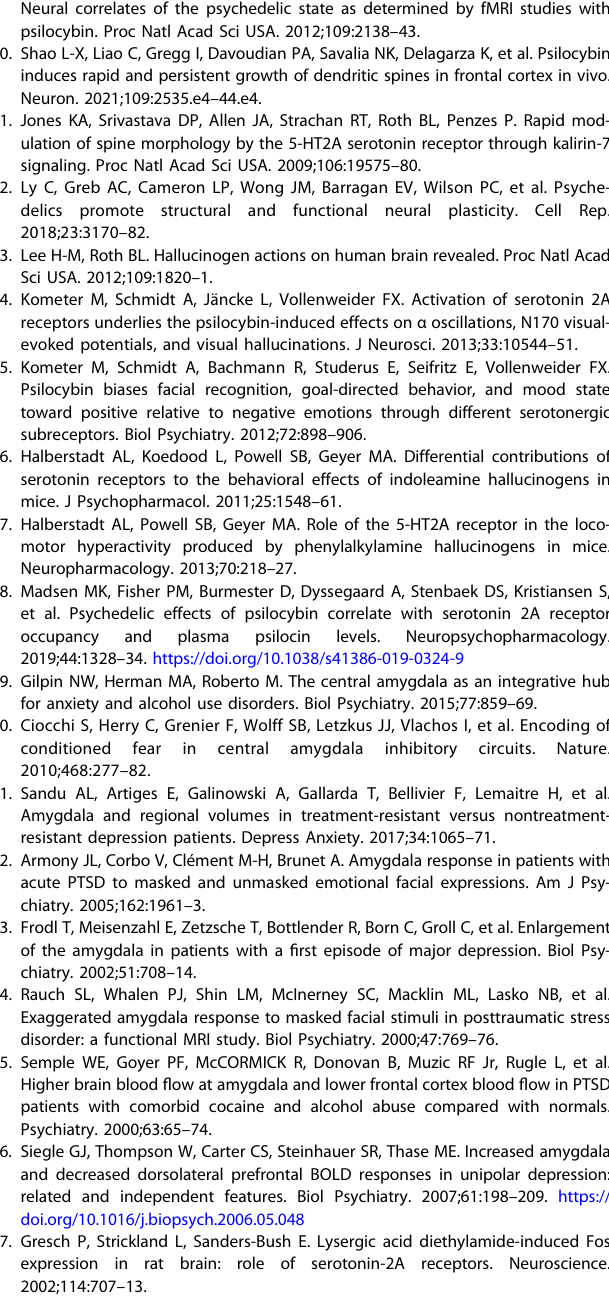
Fig. 6 Changes in CeA reactivity in response to an auditory stimulus following psilocin administration in male subjects. A Male vehicle group: representative mean Δ F / F traces showing an individual at initial auditory compared to fi nal auditory. Blue line = air-puff onset, Gray lines = individual traces, Green line = mean trace, Std standard deviation. B Male vehicle group: peak point of binned mean Δ F / F traces compared between initial and fi nal auditory recordings. Data points represent each individual subject ’ s peak Δ F / F value + / − S.E.M. C Male vehicle group: air-puff trace plots of changes in CeA fl uorescence following exposure to a 500 ms air-puff at 85 psi. Data points represent group averages within 500 ms binned window + / − S.E.M. D Male vehicle group: Heatmaps comparing initial to fi nal auditory. Each row represents an individual subjects mean trace. E Male psilocin group: representative mean Δ F / F traces showing an individual at initial auditory compared to fi nal auditory. Blue line = air-puff onset, Gray lines = individual traces, Green line = mean trace, Std standard deviation. F Male psilocin group: peak point of binned mean Δ F / F traces compared between initial and fi nal auditory recordings. Data points represent individual subject ’ s peak Δ F / F value + / − S.E.M. G Male psilocin group: air-puff trace plots of changes in CeA fl uorescence following exposure to a 500 ms air-puff at 85 psi. Data points represent group averages within 500 ms binned window + /- S.E.M. H Male psilocin group: Heatmaps comparing initial to fi nal auditory. Each row represents an individual subjects mean trace. In each trace bin plot panel, a signi fi cant increase in Δ F / F was determined whenever the lower bound of the 99% CI was >0. These points of statistical signi fi cance are shown as colored lines above each Δ F / F curve with colors corresponding to the respective binned traces with a * above the